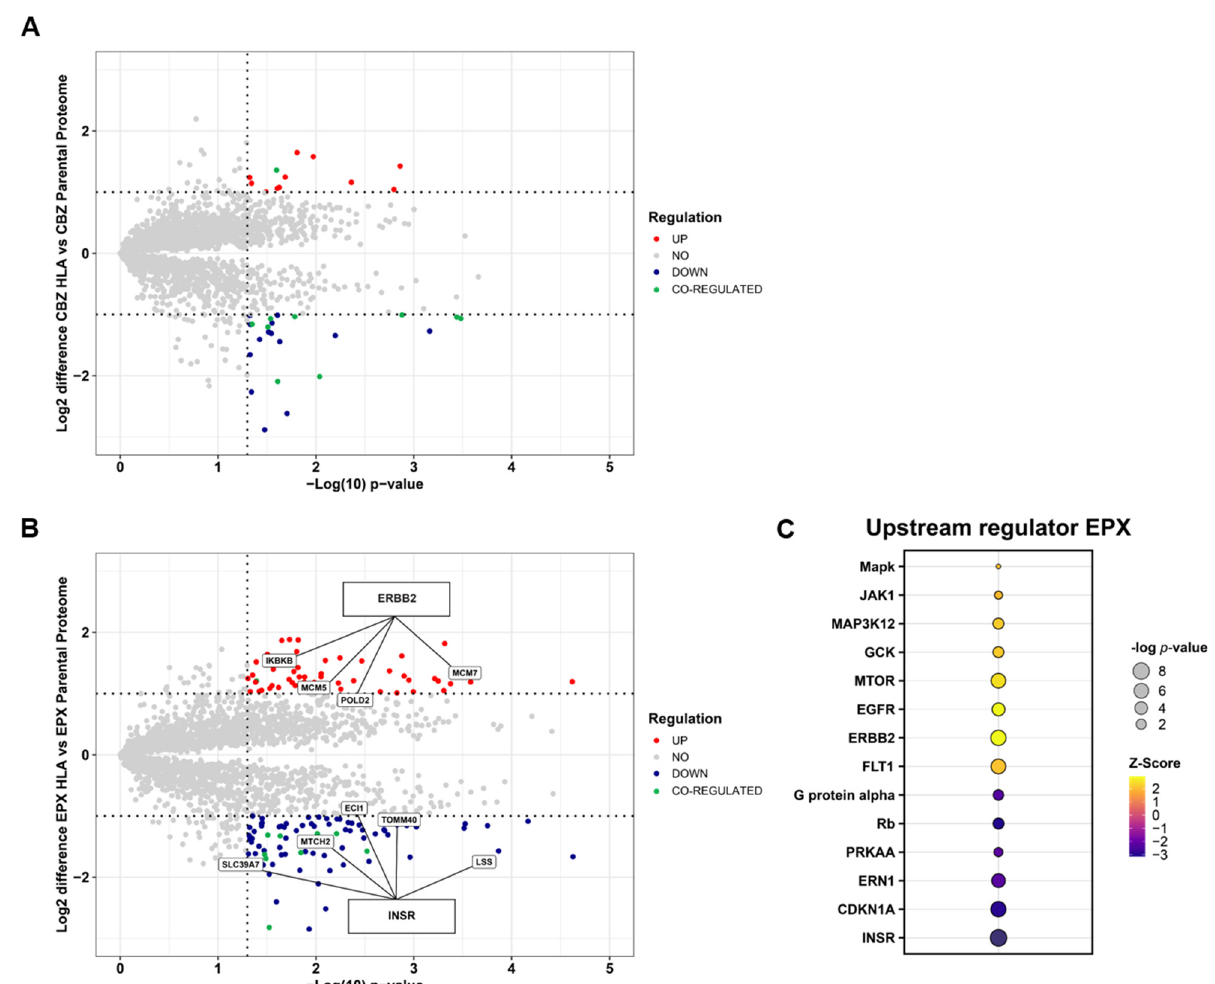
Figure 3. Analysis of proteomic changes and predicted upstream regulators after treatment of LCL721.221/sHLA-B*57:01 and parental LCL721.221 cells with CBZ or EPX. ( A ) Volcano plot of protein expression in LCL721.221/sHLA-B*57:01 vs. parental LCL721.221 cells after CBZ treatment. ( B ) Volcano plot of protein expression in LCL721.221/sHLA-B*57:01 vs. parental LCL721.221 cells after EPX treatment. Highlighted proteins were predicted to be responsive to the predicted upstream regulator ERBB2 or ISNR after EPX treatment and are altered significantly with at least a two-fold change in expression. Horizontal dotted line indicates two-fold difference, vertical line p -value threshold of p < 0.05, blue dots: significant two-fold downregulation, red dots: Two-fold significant upregulation. Up- and downregulated proteins that overlap between CBZ- and EPX-treated cells are depicted in green. ( C ) Predicted upstream regulators by IPA™.